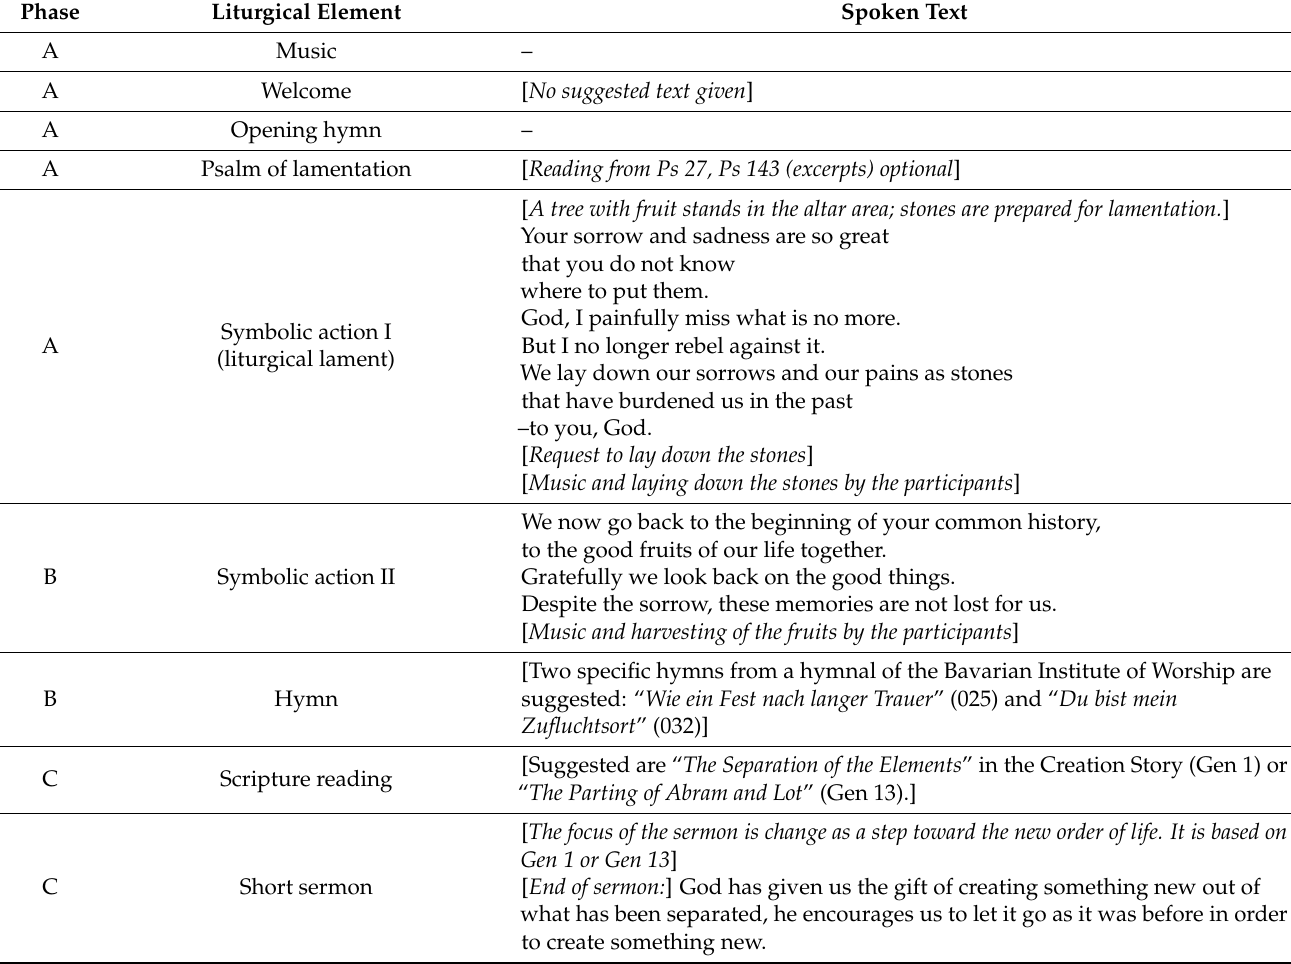
Table A3. Structure of The Three Pillar Model